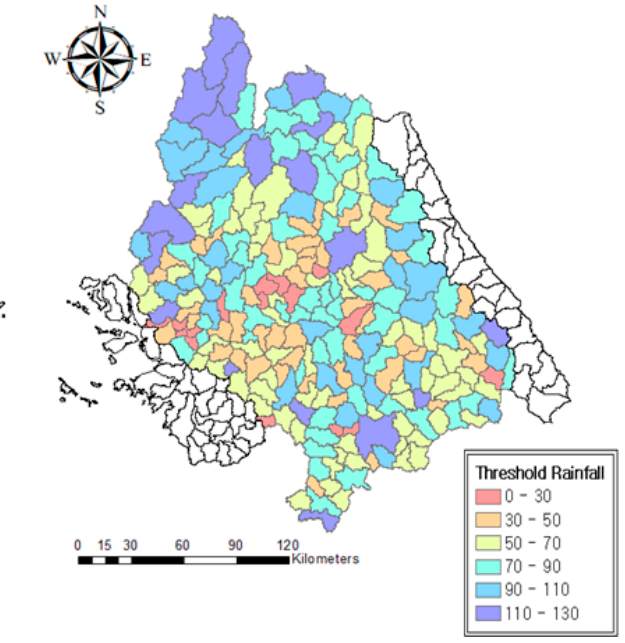
Figure 8. Standard watershed Threshold rainfall.